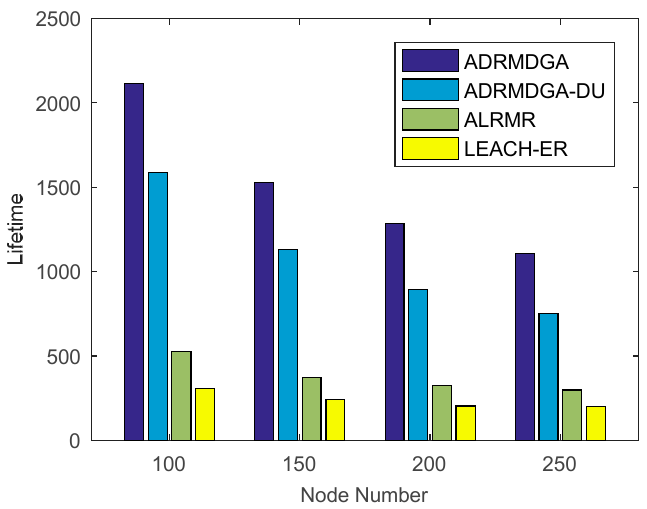
Figure 6. Impact of node number on network lifetime in different algorithms (P = 0.3 W).